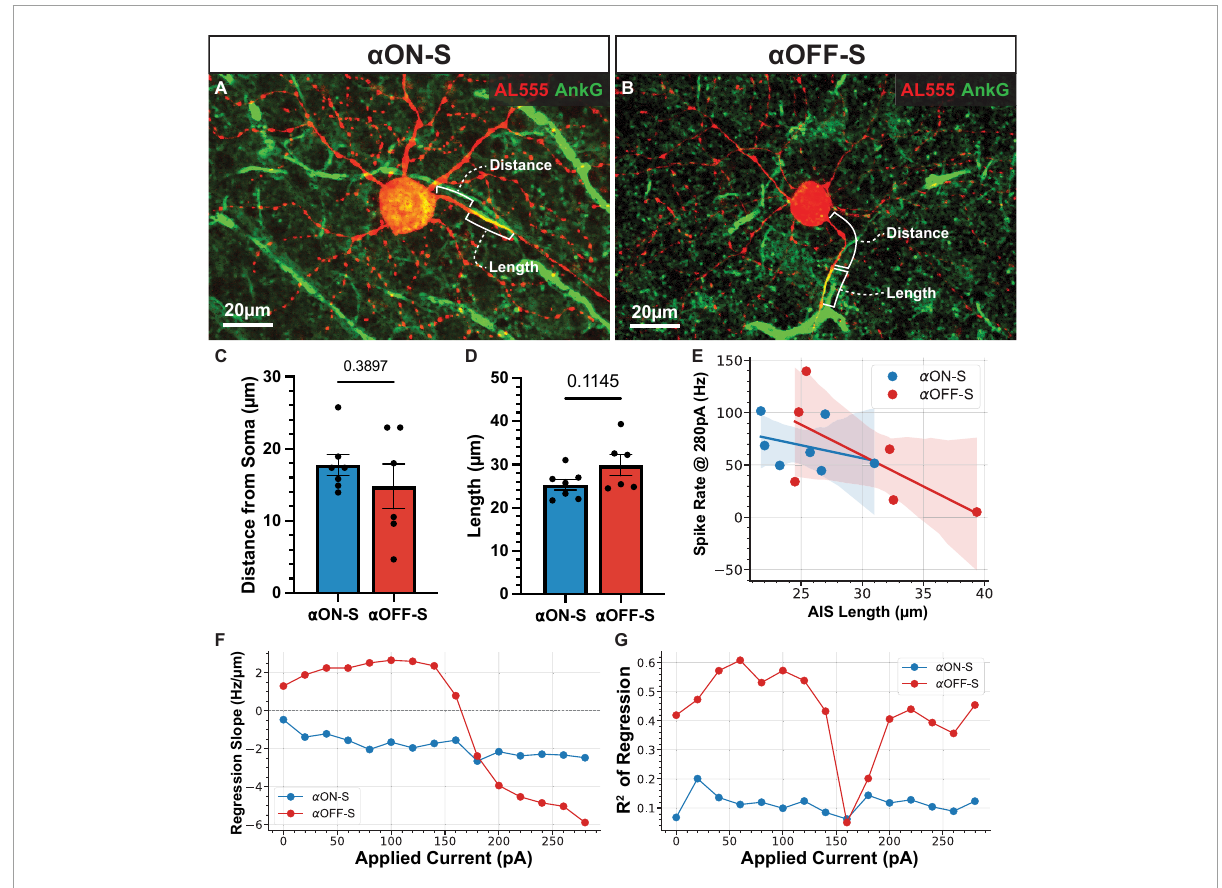
FIGURE7 The relationship between axon initial segment (AIS) length and evoked spike rate varies by cell type and strength of stimulation. (A,B) Representative images of Alexa 555 (AL555, red) dye-filled alpha ON-Sustained ( α ON-S) (A) and alpha OFF-Sustained ( α OFF-S) (B) retinal ganglion cells (RGCs) labeled for the AIS protein ankyrin-G (AnkG, green). Annotations demonstrate the dimensions of AIS distance from soma and length which are quantified below. (C,D) AIS distance from soma (C) and length (D) do not differ significantly between the two RGC types ( p = 0.38397, unpaired t -test; p = 0.1145, unpaired t -test). Error bars: ± standard error of the mean. (E) Example scatter plot and linear regression best fit lines of the relationship between AIS length and current-evoked spiking rate, for 280 pA current injection. Shaded regions are 95% confidence intervals for best fit lines. (F) The slope of the regression best fit lines at each test current for α ON-S and α OFF-S RGCs. (G) R 2 values of the linear fits at each test current for α ON-S and α OFF-S